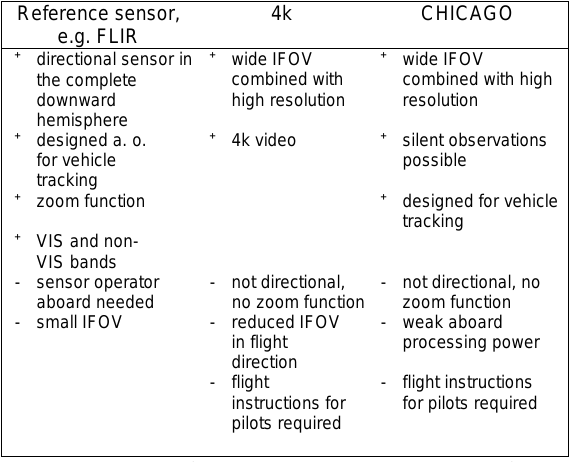
Table 1: Potential of 4k and CHICAGO sensor system for long-term vehicle tracking in comparison with a reference